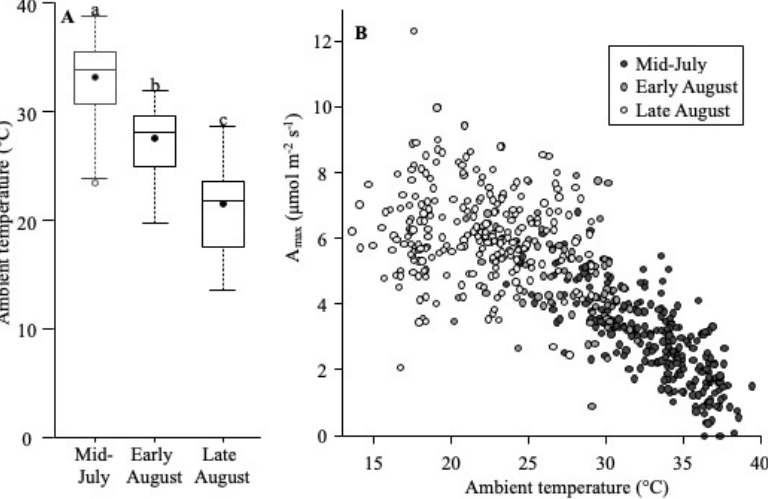
Figure 5. Changes in ambient temperature on the experimental plots during the growing season ( A ) and relationship between maximum photosynthetic rate (A max ) and temperature ( B ). Points and letters ( A ) represent means and significant differences from the 5% level (Tukey test), respectively.